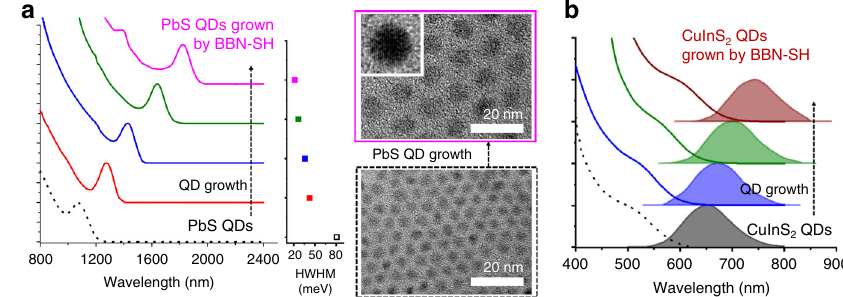
Fig. 5 Successful growth of high-quality PbS and CuInS 2 QDs using BBN-SH. a Absorbance spectra of PbS QDs during growth. HWHM (meV) progressively narrows during growth (PbS nuclei: black, PbS QDs grown by BBN-SH: other colors). The TEM images of the fi nal QDs and PbS nuclei. (inset: HRTEM image; scale bar: 20 nm). b Absorbance and PL spectra of CuInS 2 QDs during growth (CuInS 2 nuclei: black; CuInS 2 QDs grown by BBN-SH: